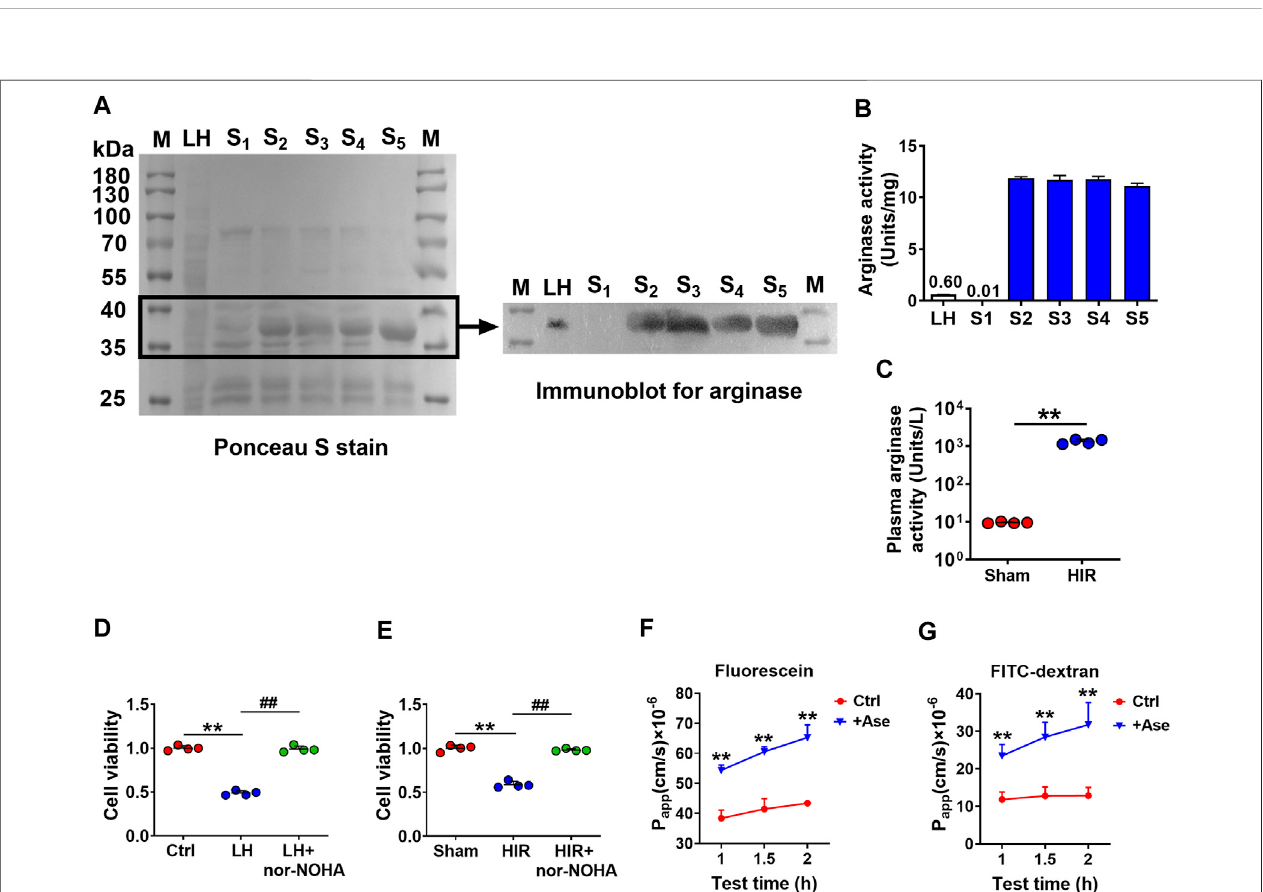
FIGURE3 | Arginase wasveri fi ed tobe thetoxic molecule tohCMEC/D3cells. (A) PonceauS stainon thewholemembraneand immunoblot image for arginase in fi nally puri fi ed protein samples S1 ∼ S5 (20 μ g) compared with rat liver homogenate (LH) (20 μ g) (M, molecular weight marker). (B) Arginase activity assay in S1 ∼ S5 and LH.(C)Plasmaarginaseactivityinhepaticischemia-reperfusion(HIR)rats(1 hischemiaand4 hreperfusion)andsham-operated(Sham)rats( n (cid:2) 4). (D) Effectofarginase inhibitor nor-NOHA (50 μ M) on damaged viability of hCMEC/D3 cells caused by LH (200 μ g/ml) or (E) 10% serum of HIR rats ( n (cid:2) 4). (F) Apparent permeability coef fi cients (P app ) assay of fl uorescein and (G) FITC-Dextran across hCMEC/D3 in vitro BBB treated with arginase (20 μ g/ml) (Ase) ( n (cid:2) 6). Data were expressed as mean ± SD.** p < 0.01versuscontrolcells(Ctrl)orShamrats; ## p < 0.01versuscellstreatedwithLHorHIRratserum;1-wayANOVAfollowedbyDunnett ’ s posthoc test or unpaired t -test in panel (C)